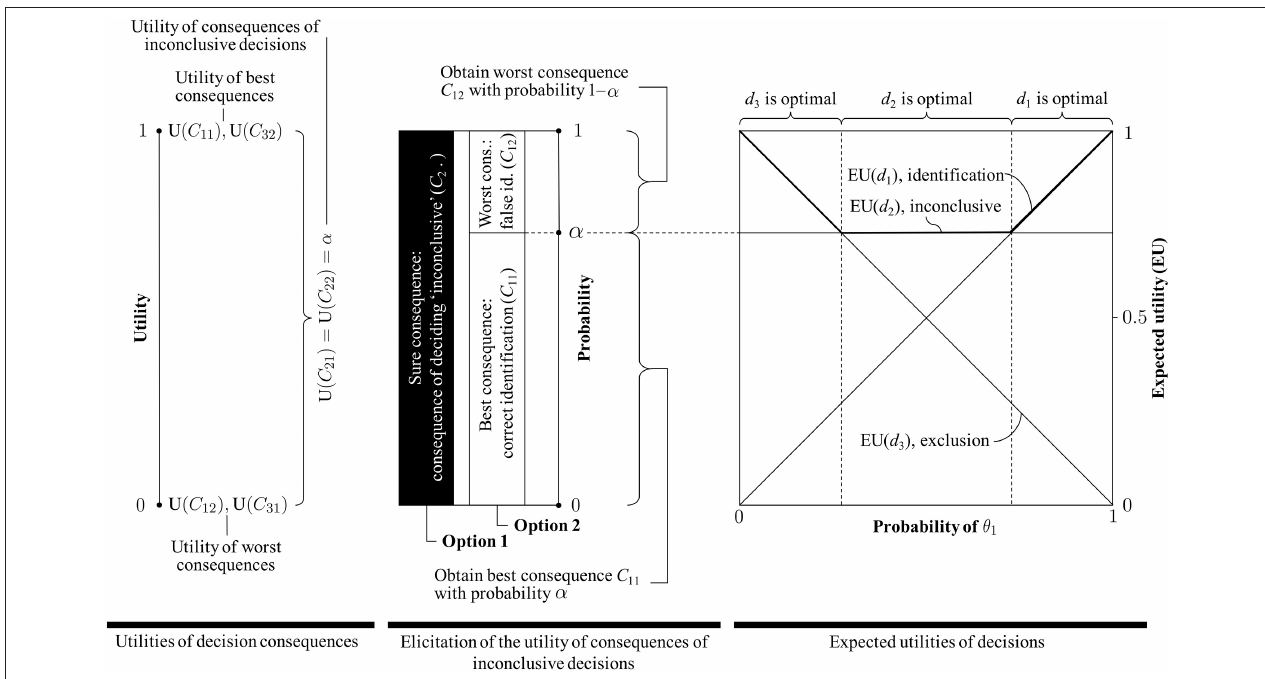
FIGURE 3 | (Left) Definition of the (0,1) utility scale and assignment of utilities of 1 to the best decision consequences (i.e., correct identification, C 11 , and correct exclusion, C 31 ) and utilities of 0 to the worst consequences (i.e., false identification, C 12 , and false exclusion, C 31 ). The utility α of the consequences of inconclusive decisions can take any value between 0 and 1, including these endpoints. (Middle) Elicitation of the utility for consequences of inconclusive decisions based on a comparison between two options. The utility of an inconclusive decision is obtained as the probability α with which Option 2 leads to the best consequence (and with probability (1 − α ) to the worst consequence), such that Option 2 is as desirable as Option 1 (which offers the consequence of an inconclusive decision for sure). (Right) Representation of the expected utilities of decisions “identification” ( d 1 ), “inconclusive” ( d 2 ) and “exclusion” ( d 3 ) (the bold line indicates the decision with the highest expected utility). The vertical dashed lines indicate transition points, i.e., where one decision becomes preferable to another decision (i.e., where one decision has a higher expected utility than another). Note, in particular, that the smaller the acceptable probability (1 − α ) for a false identification ( C 12 ) elicited in the procedure illustrated in the Figure in the middle, the closer to 1 the expected utility of the decision “inconclusive” in the Figure on the right, and hence the smaller the ranges of probabilities for θ 1 (i.e., the proposition according to which the person of interest is the source) for which either “identification” or “exclusion” will be the optimal decisions (i.e., decisions with the highest expected utility). In the extreme case, when the acceptable probability (1 − α ) for incurring a false identification is zero, the expected utility of the decision “inconclusive” is 1, and hence maximal, in all cases (i.e., regardless of the probability of θ 1